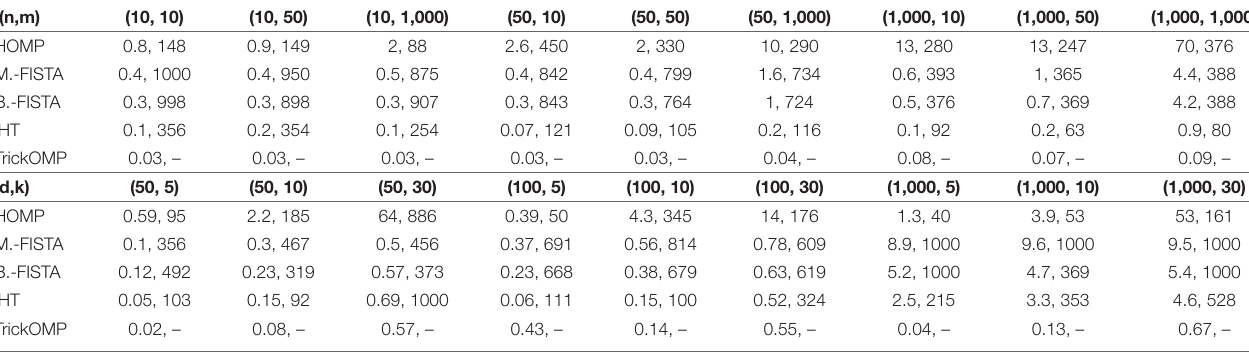
TABLE 1 | Average computation time in seconds and number of iterations with respect to ( n , m ) and ( k , d ).